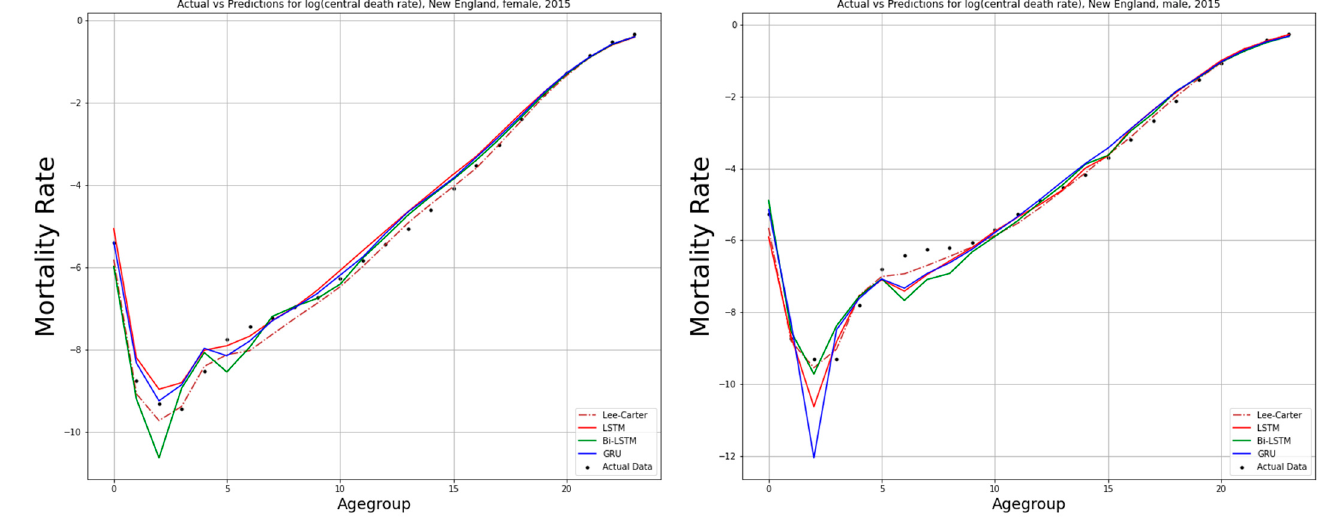
Figure 10. The predictions of the log-mortality rate for New England female ( left ) and male ( right ), 2015: LC (red) vs. actual (blue).